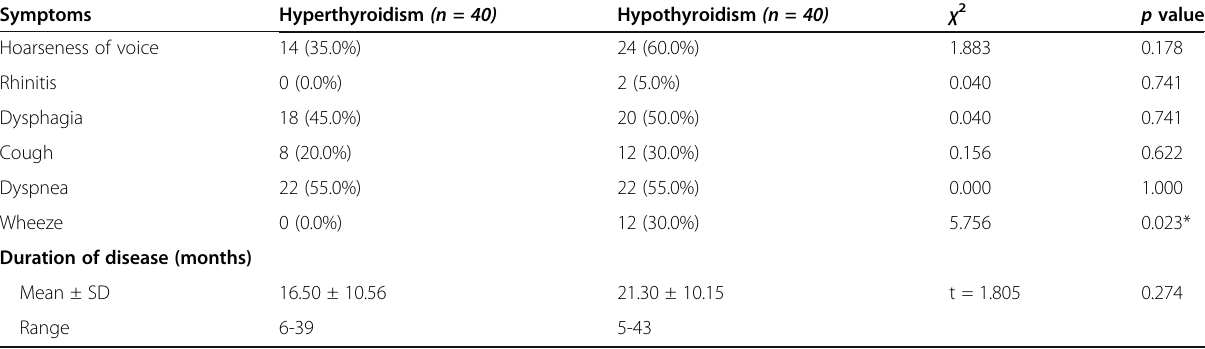
Table 2 Comparison between groups according to upper and lower respiratory symptoms Symptoms Hyperthyroidism (n = 40) Hypothyroidism (n = 40) χ 2 Hoarseness of voice